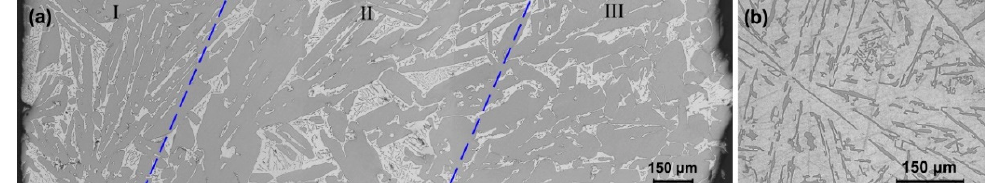
Figure 7. Microstructures of ( a ) the Si-rich layer and ( b ) the Si-poor region of the Al-30Si alloy under the best separation condition.